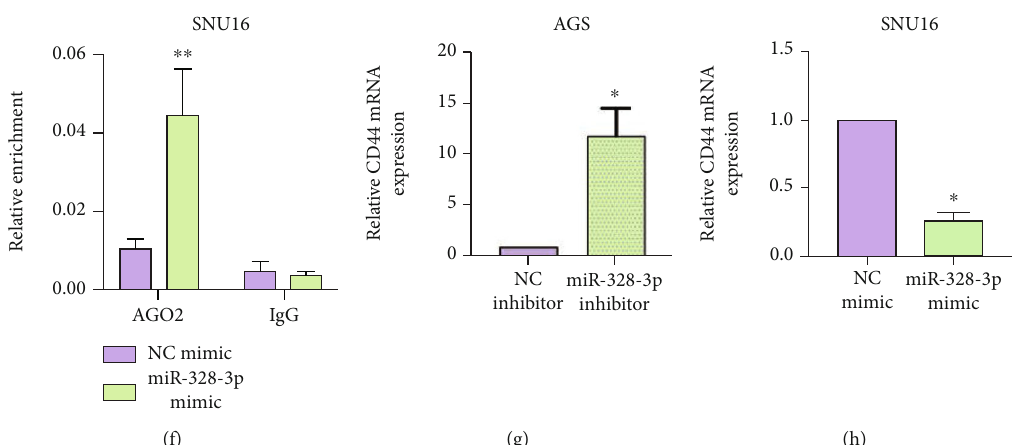
Figure 3: miR-328-3p negatively modulated CD44 expression. (a) The GEPIA2 and miRTarBase databases were used to identify overlapped genes. (b) The top 10 bottleneck proteins and top 10 hub proteins were selected by utilization of bottleneck and degree algorithm, respectively. (c) The association between CD44 and the prognosis of STAD patients. (d) The CD44 coexpressed genes were predicted to be enriched in 7 GO terms. The x -axis represented the gene ratio, and the intensities of di ff erent colors represented the adjusted P value. (e) The binding sites between miR-328-3p and CD44 predicted by TarBase database were shown. Dual-luciferase reporter assay was employed to evaluate their interaction. (f) RIP assay was also performed to verify the relationship between miR-328-3p and CD44. (g, h). qRT-PCR was utilized to detect the expression level of CD44 in (g) miR-328-3p-downregulated AGS cells and (h) miR-328-3p- overexpressed SNU16 cells. All experiments were performed in triplicate. ∗ P < 0 : 05 , ∗∗ P < 0 : 01